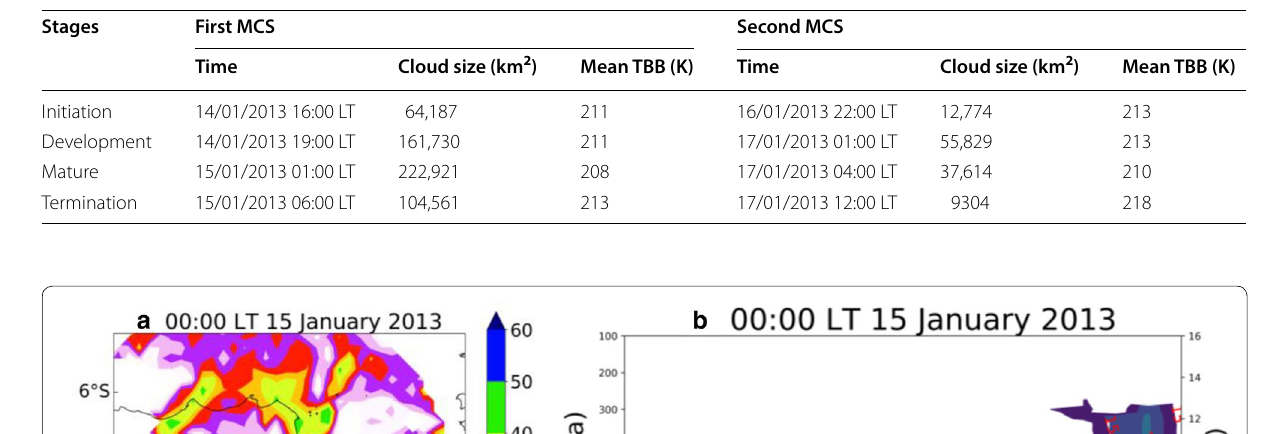
Table 4 The MCS feature of two MCSs over the GJ